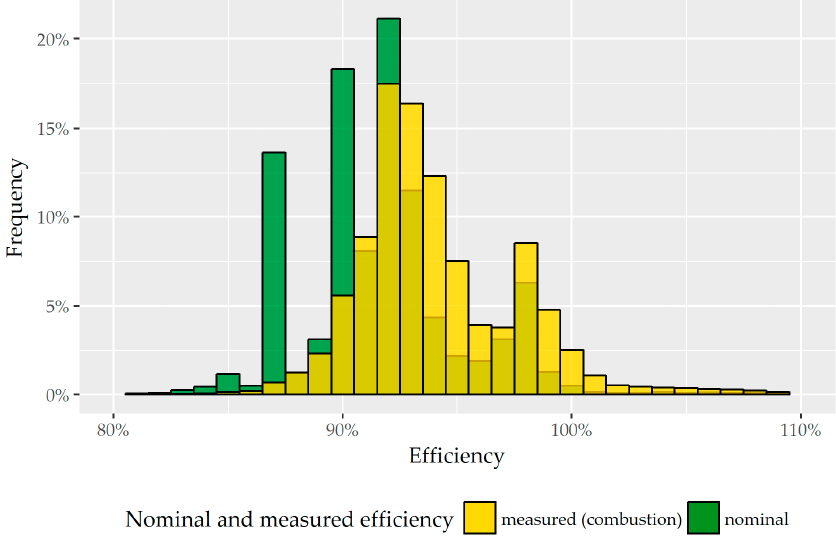
Figure 7. Distributions of nominal and measured (combustion) efficiency for Natural Gas boilers.